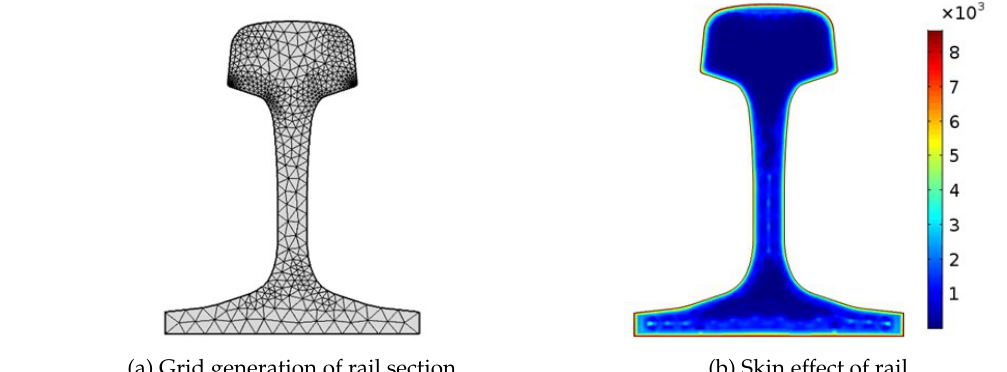
Fig. 4. Mesh generation and skin effect of rail section.